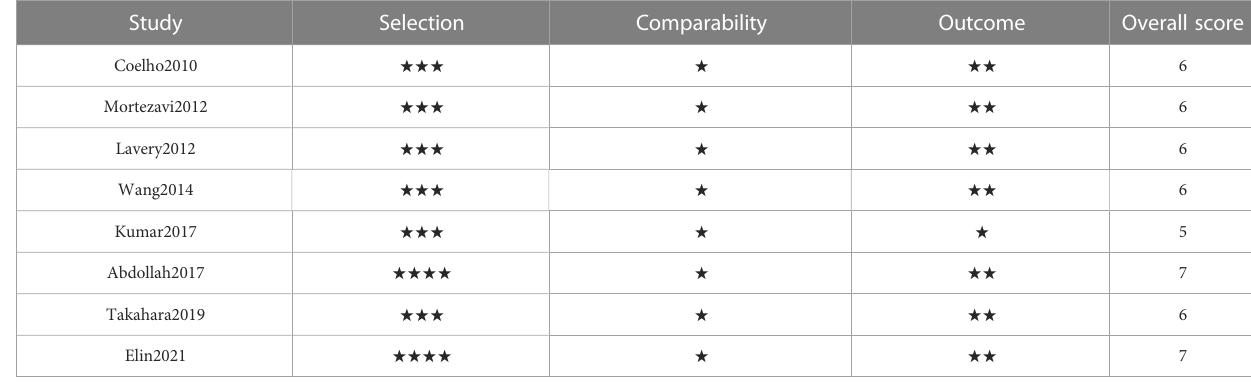
TABLE 3 The risk of bias table.